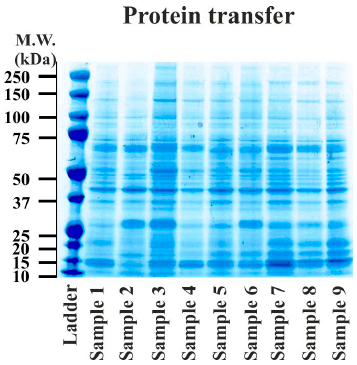
Figure A1. Coomassie staining of a PVDF membrane showed the homogeneity and completeness of the spinal gel filtration fractions transfer from the NuPAGE 4–12% Bis-Tris gel.